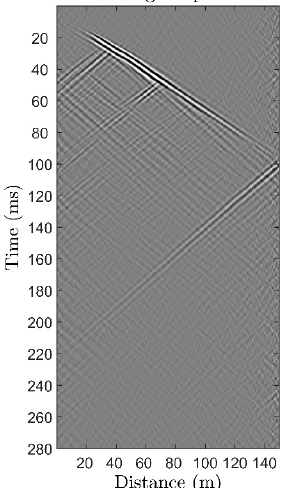
Figure 8. The result of ZVSP using the proposed DAS with averaging over 3600 acoustic impacts. The waveform was f-k-filtered to remove hydroacoustic waves and environmental noise.